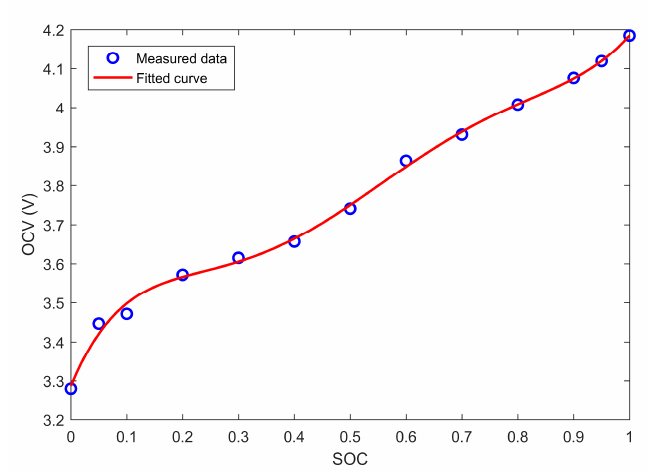
Figure 4. Measured and fitted OCV-SOC curve for 25 °C.